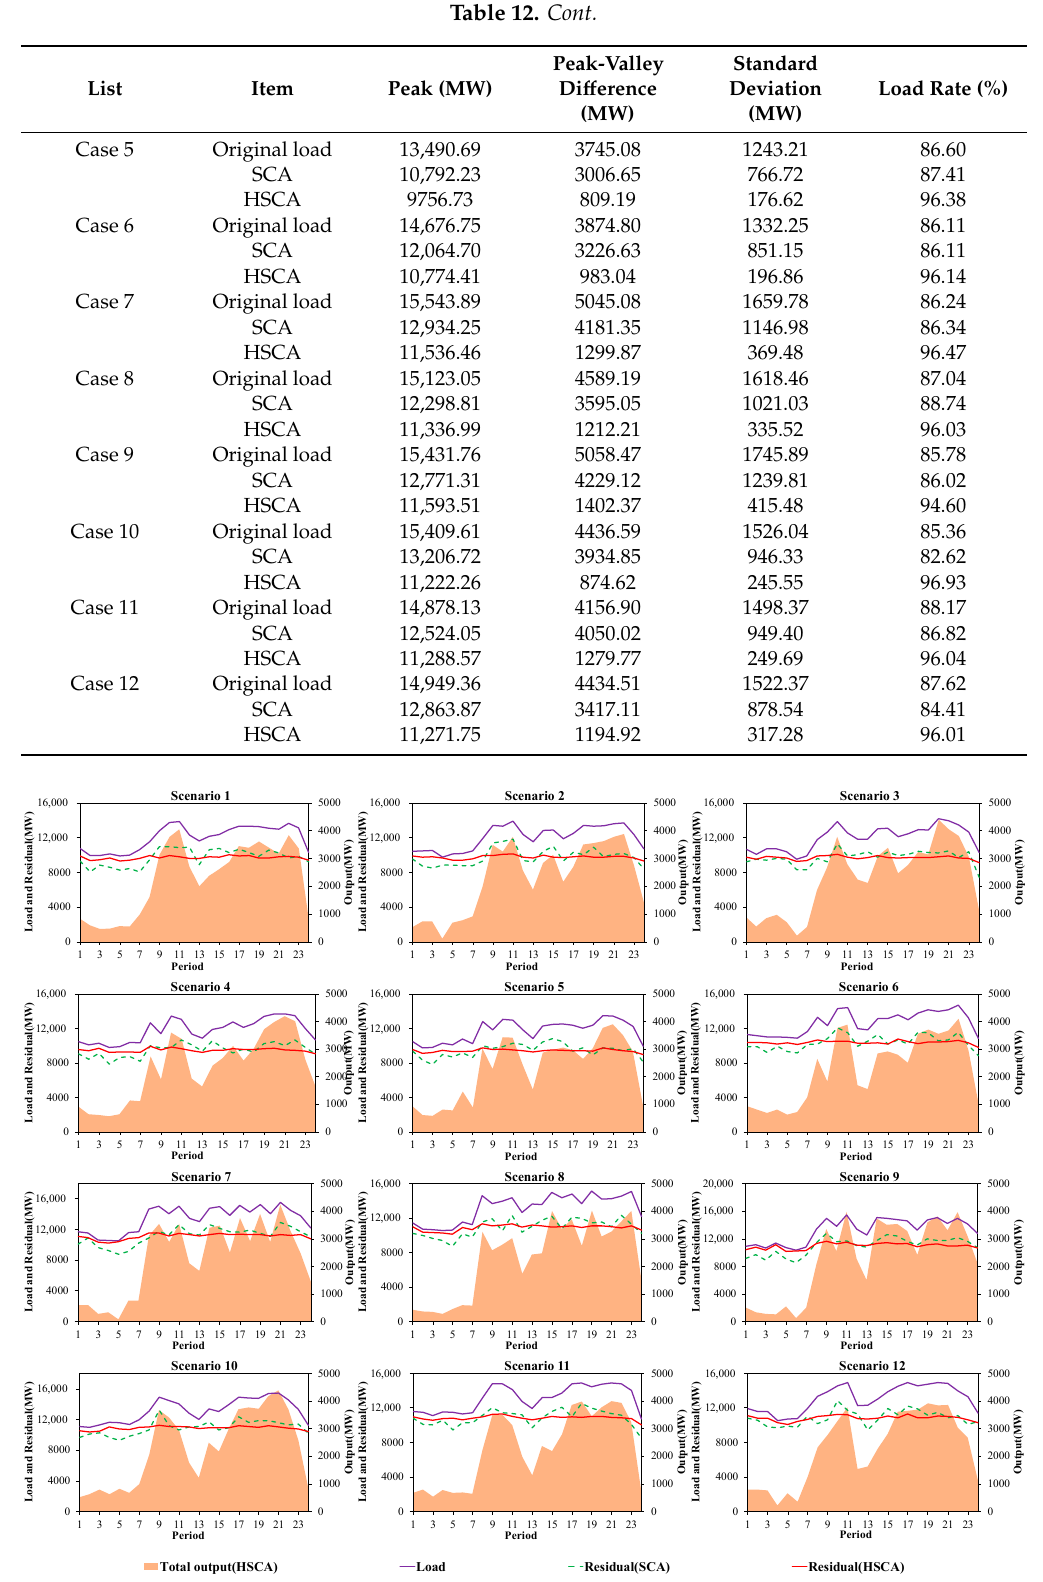
Figure 15. Comparison of different methods in 12 cases.